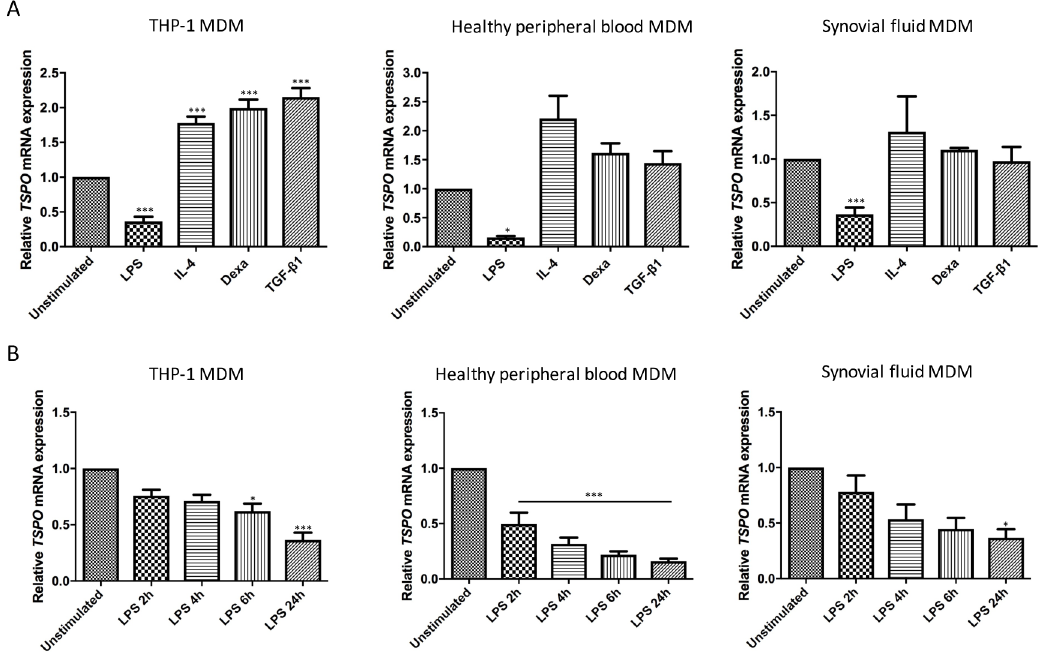
Fig 5. Relative TSPO mRNA expression in MDM from THP-1, healthy human peripheral blood, and RA synovial fluid. MDMs were stimulatedwith: (A) 10ng/mLLPS plus 20ng/mLIFN- γ , 20ng/mLIL-4, 500nMdexamethasone or 3ng/ mL TGF- β 1 for 24 hours, or (B) LPS plus IFN- γ for 2, 4, 6 and 24 hours. Each experiment was run in triplicate, with data expressedas mean of five independentexperiments ± SEM and comparedto unstimulated control cultures. ( * p < 0.05, ** p < 0.01, *** p (cid:20) 0.001).